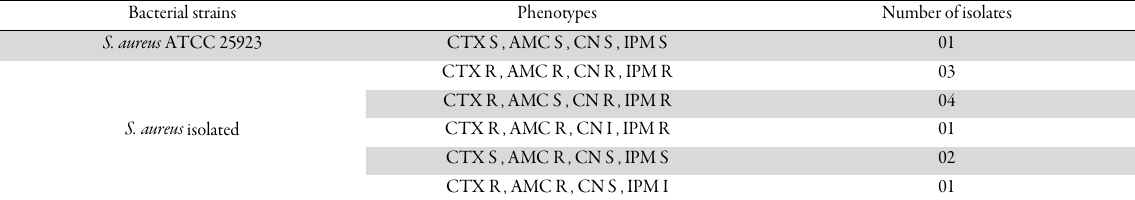
Table 3. Resistance profile of Staphylococcus aureus strains